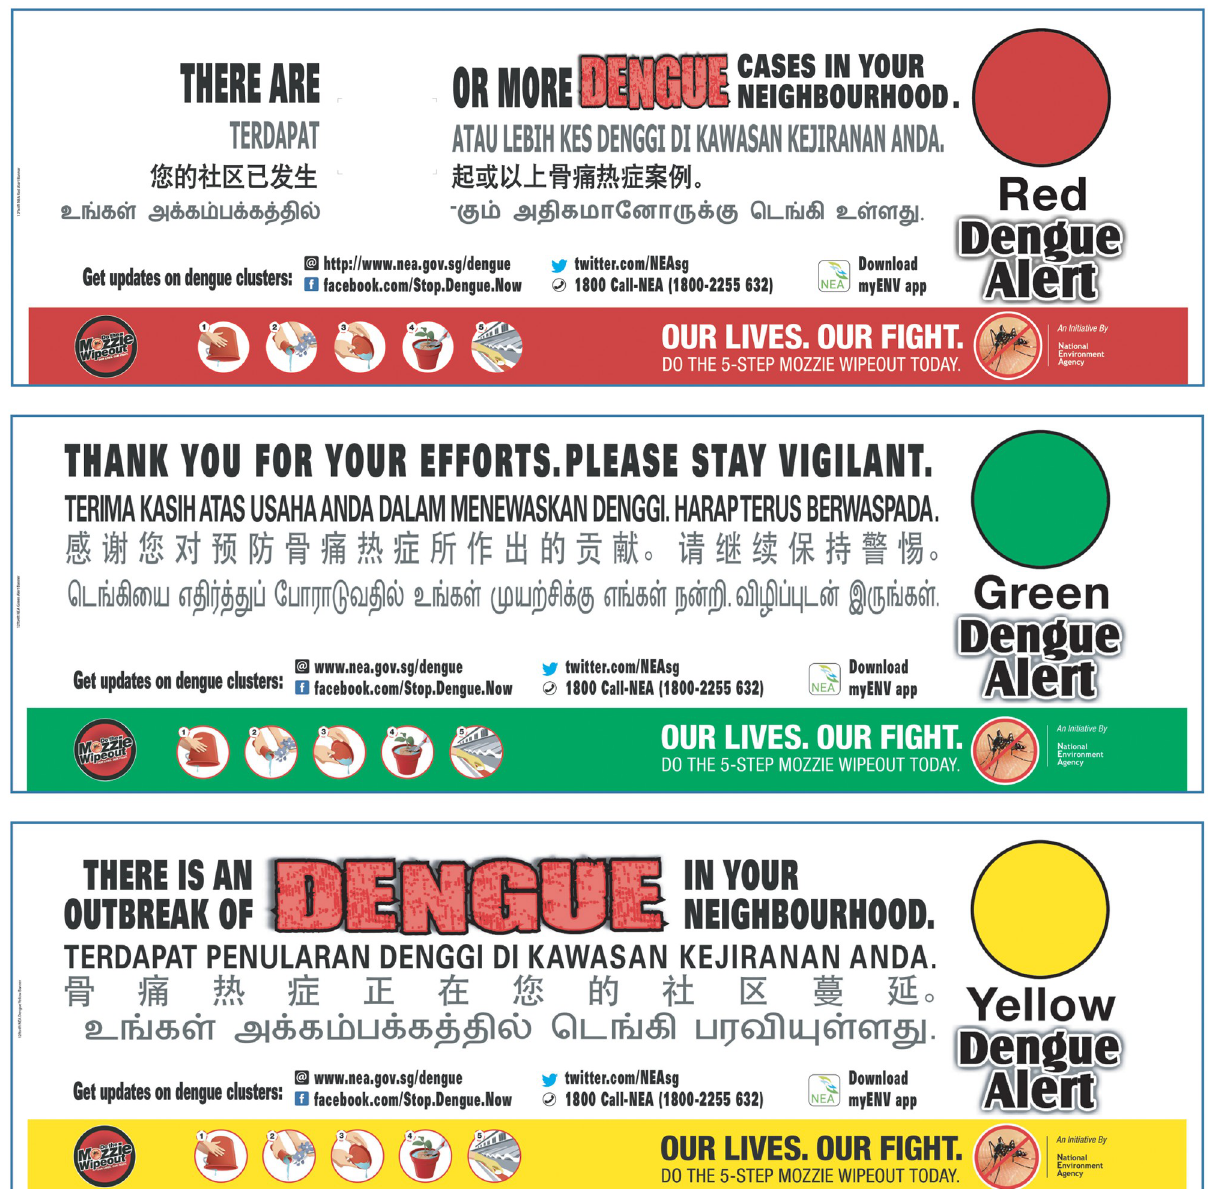
Fig 7. Colour-coded community dengue alert